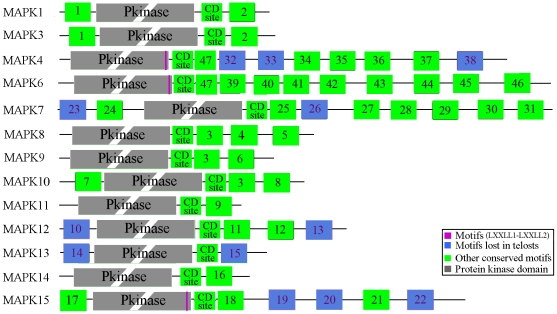
Motif distributions of the 13 vertebrate MAPK subfamiles.The protein kinase domains are drawn as grey boxes. The motifs lost in teleosts are drawn as blue and other motifs as green. The LXXLL1-LXXLL2 motifs are marked in purple. The motifs, especially the protein kinase domains, are not drawn to scale. The sequences of these motifs are given in Table S3.